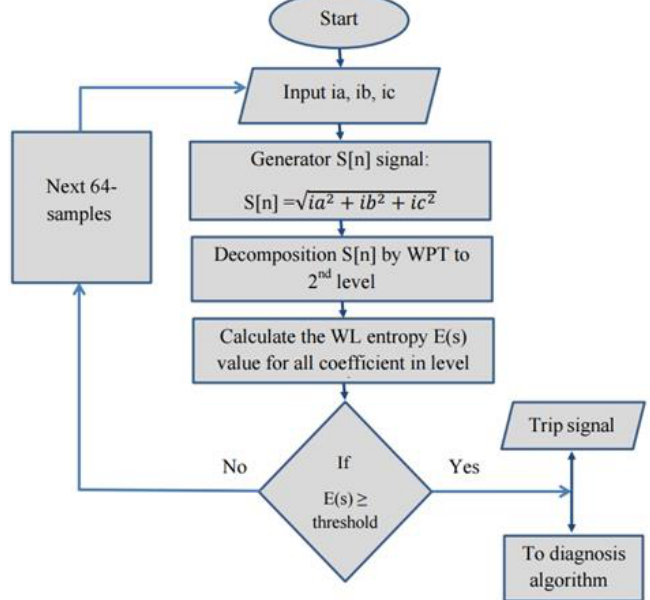
Figure 12. Fault detection using the non-overlapping window frame method.